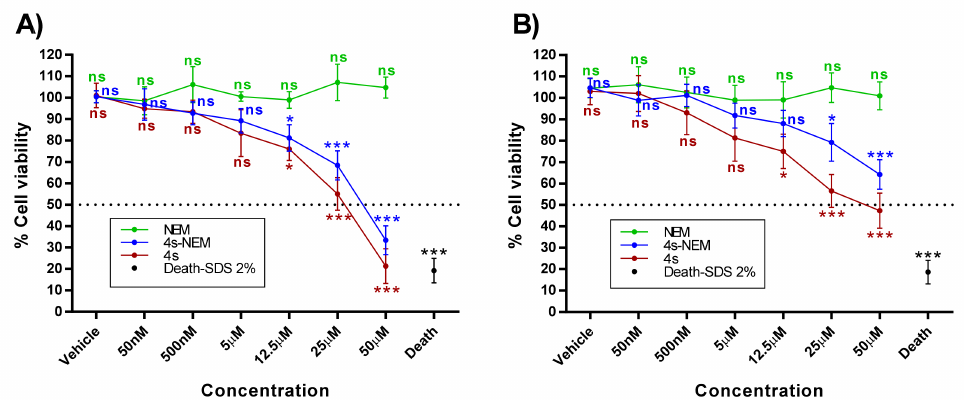
Figure 7. Effect of 4s -NEM on the viability of cancer (B16F10) and non-cancer (HEK293) cells in vitro. Cells were treated with 4s -NEM at different concentrations for 24 h and their viability was evaluated using the MTS assay; SDS, the vehicle for NEM, and 4s free in the culture medium were used as controls. The IC 50 was determined in each case. ( A ) Effect of 4s -NEM on B16F10 cells. Six independent experiments were performed in triplicate. Results are shown as the mean ± SEM. ( B ) Effect of 4s -NEM on HEK293 cells. Results are shown as the mean ± SEM of three separate experiments. (***) p < 0.001, (*) p < 0.05 vs. control, ns = non-significant. Data analysis was performed via a 2-way ANOVA Tukey’s multiple comparisons